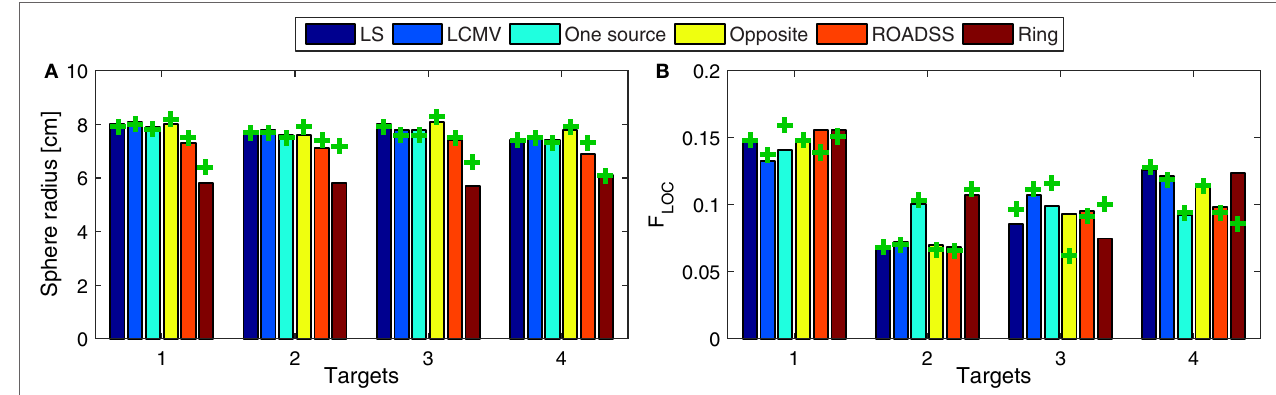
FIGURE 13 | Focality. (A) Focality defined with the half-width at half-maximum radius approach for the whole gray matter domain (the lower the better), i.e., a global focality metric; and (B) , the local focality (the larger the better) as defined in Eq. 9. The bars depict the results for the 256 electrode net while the “ + ” marks correspond to the 128 sensor